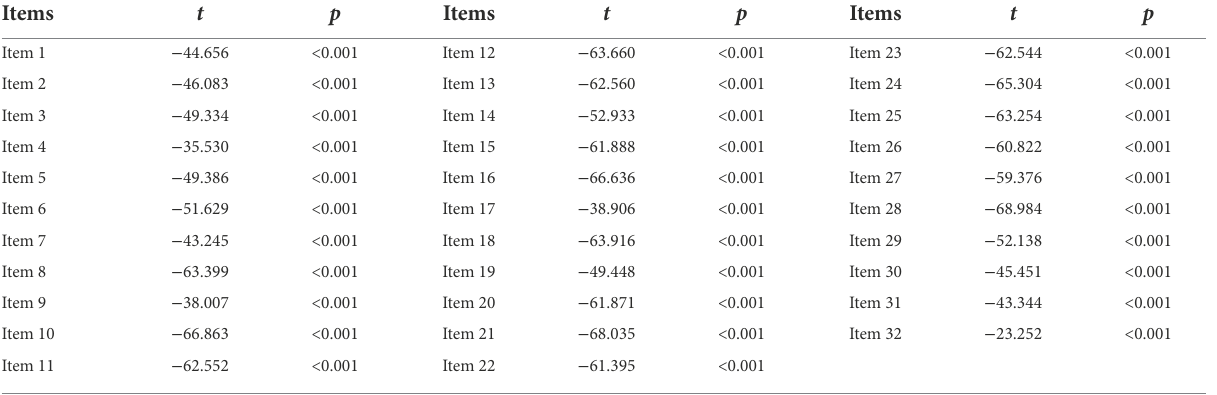
TABLE 2 Results of the t -test analysis.